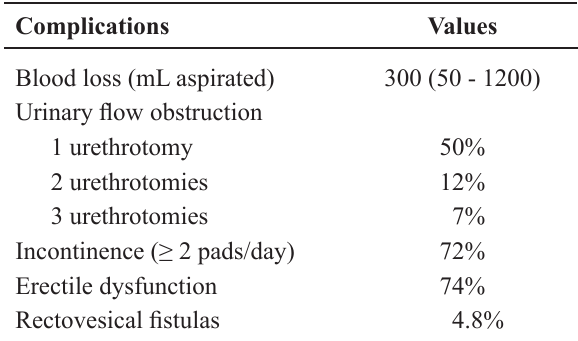
Table 3 – Main complications in 42 patients submitted to salvage radical prostatectomy